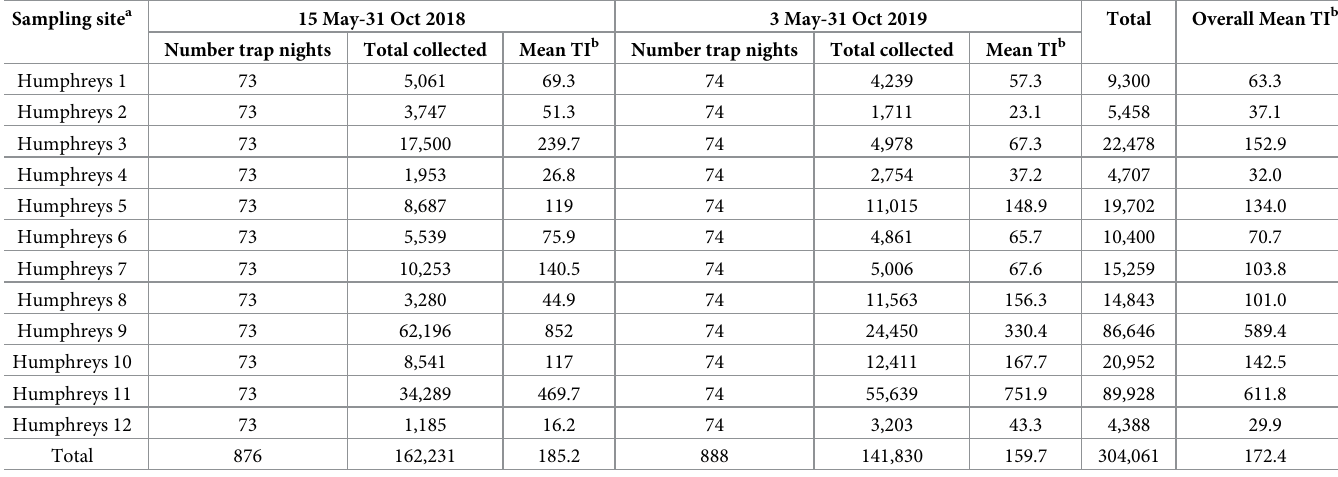
Table 2. Total number of mosquitoes collected at USAG Humphreys by Independence 1 model Mosquito Magnet 1 traps during 2018 and 2019. Sampling site